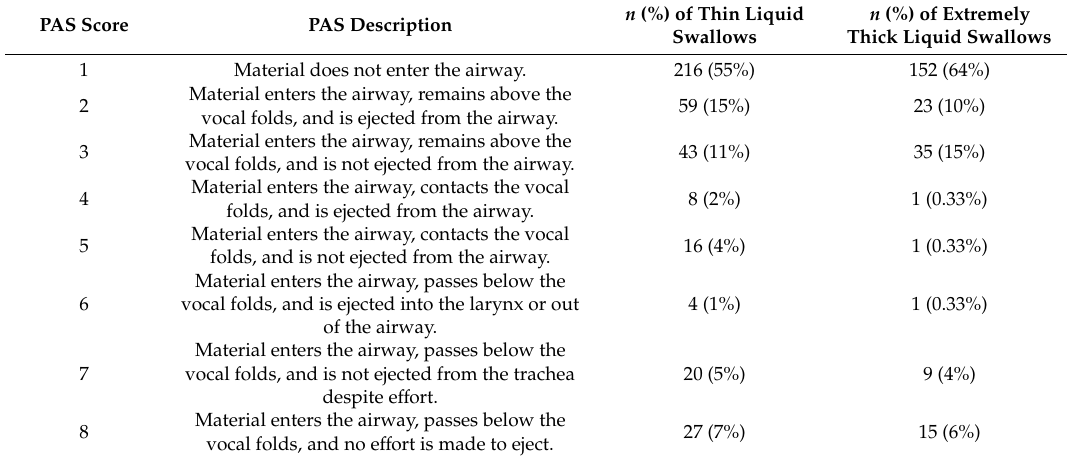
Table 1. Distribution of Penetration–Aspiration Scale (PAS) scores according to bolus viscosity.